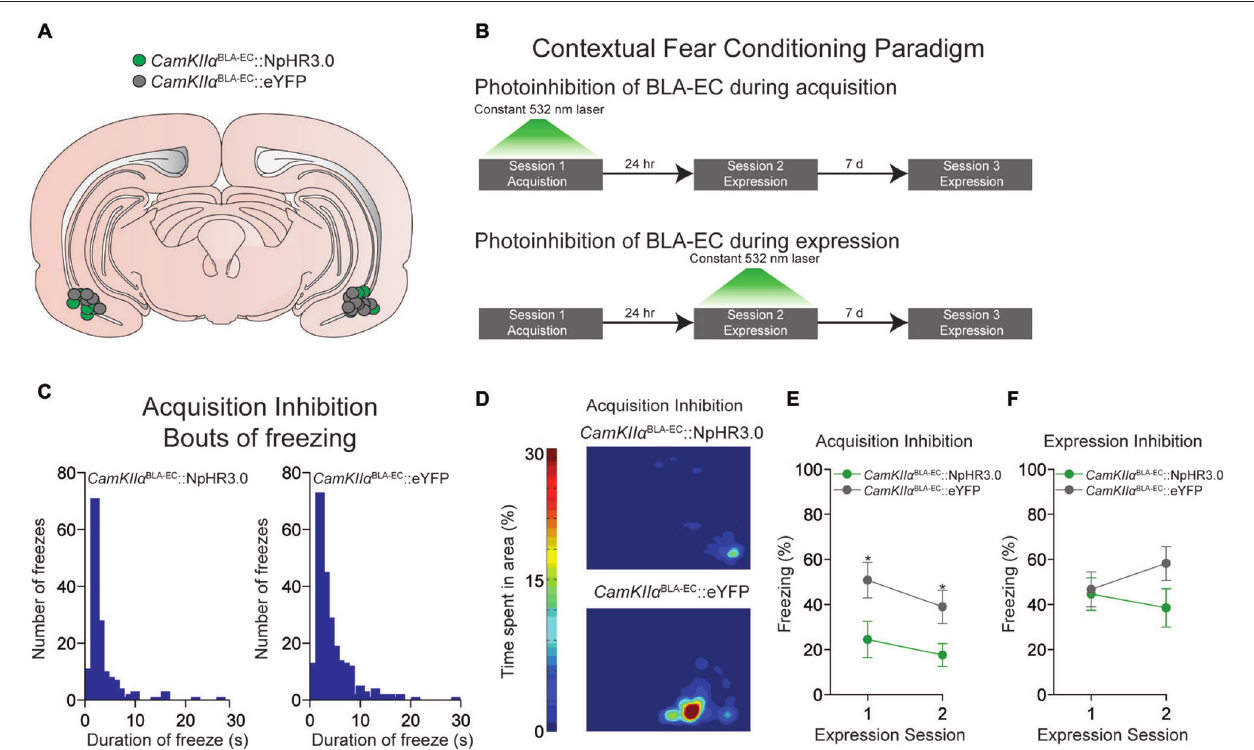
displaying average time spent in the context during the first expression session after laser inhibition during the acquisition session from CamKII α BLA-EC ::NpHR3.0 (top) and CamKII α BLA-EC ::eYFP (bottom) mice. (E) Average freezing (%) of CamKII α BLA-EC ::NpHR3.0 ( n = 8 mice) and CamKII α BLA-EC ::eYFP ( n = 8 mice) during the two expression sessions after laser stimulation during the acquisition session. CamKII α BLA-EC ::NpHR3.0 mice spent significantly less time frozen during both expression sessions compared to CamKII α BLA-EC ::eYFP. (F) Average freezing (%) of CamKII α BLA-EC ::NpHR3.0 ( n = 9 mice) and CamKII α BLA-EC ::eYFP ( n = 8 mice) during two expression sessions after laser stimulation during the 1st expression session, showing no differences between the groups. All values for all figures represent mean ± s.e.m. * P <